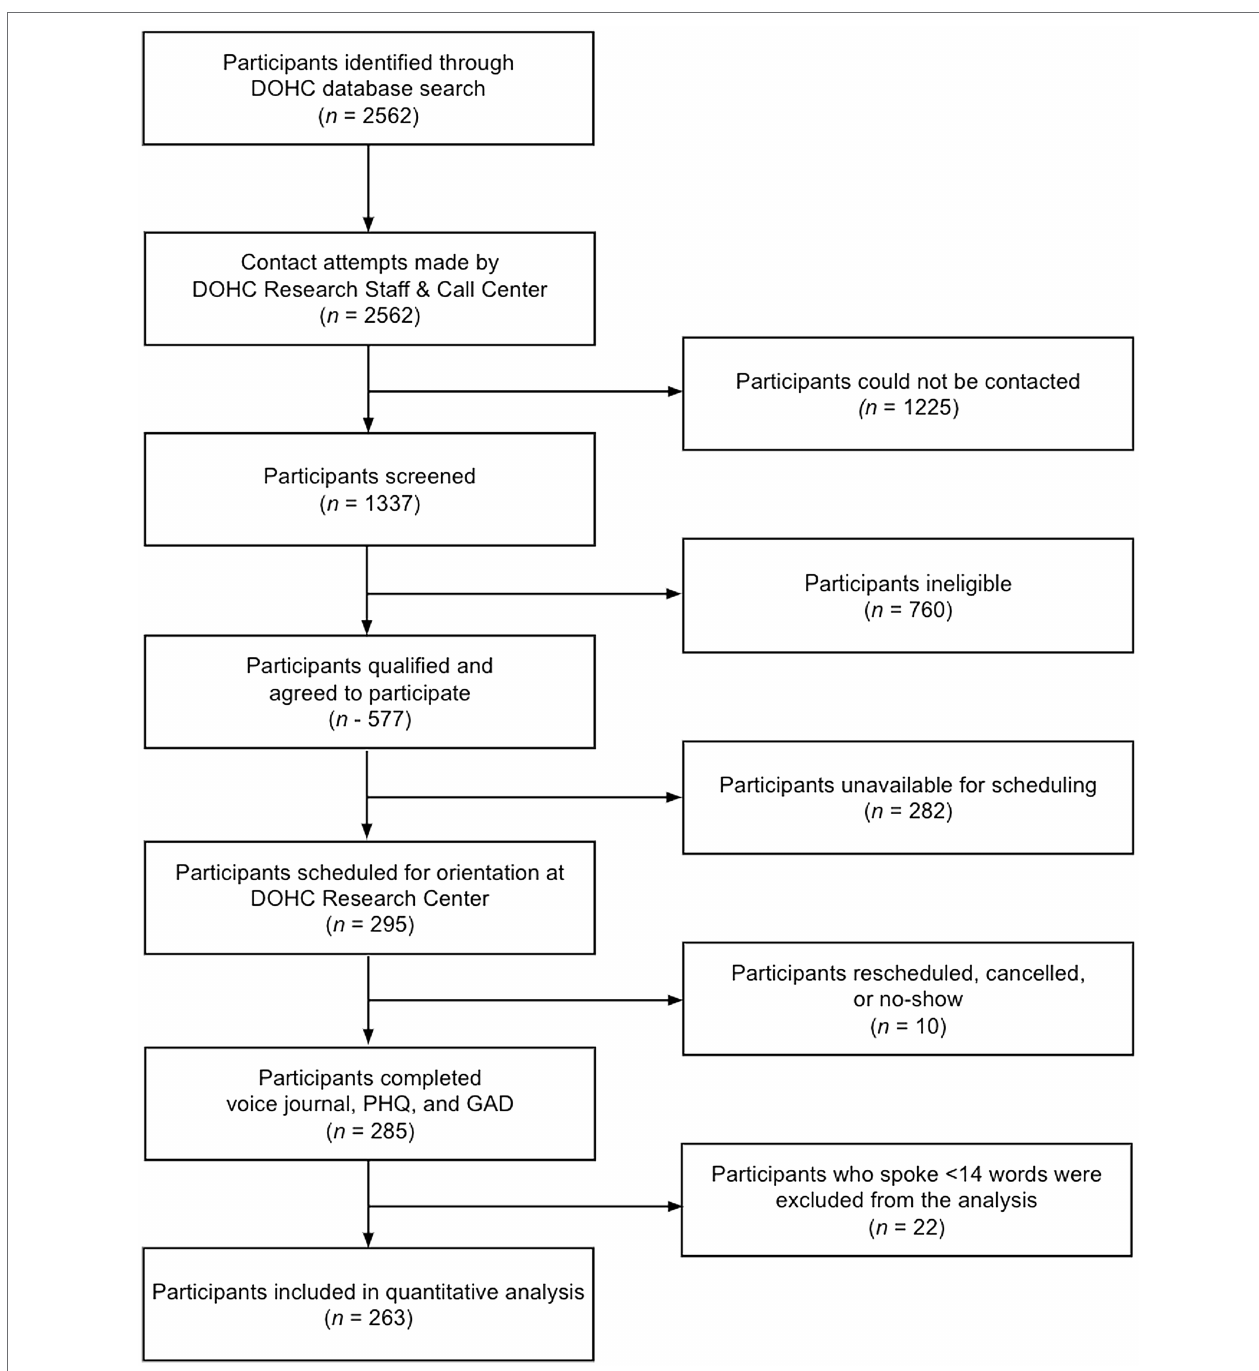
FIGURE 3 | Overall Study